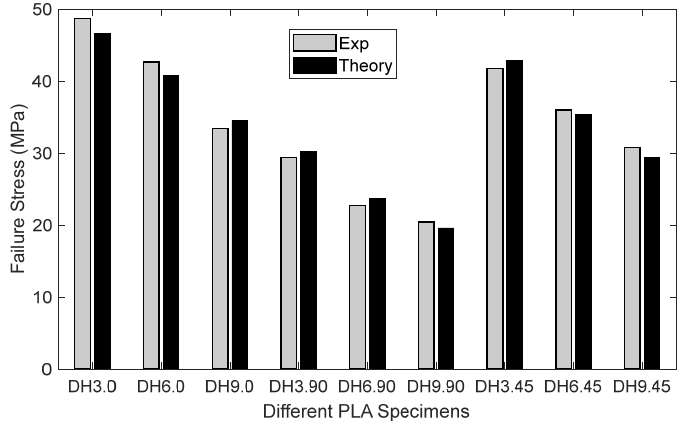
Figure 16. Experimental and theoretical failure stress for drilled PLA specimens.